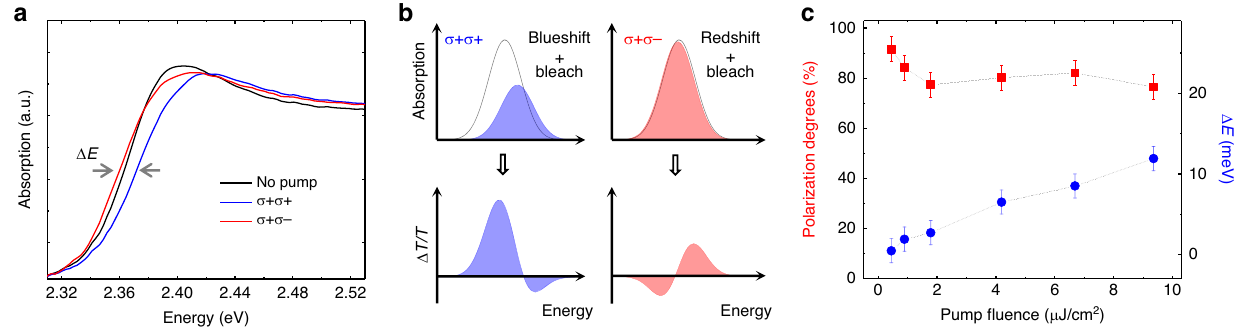
Fig. 2 The photoinduced circular dichroism in CsPbBr 3 at room temperature. a The absorption spectra without pump (black curve) and with pump at a deley time of 0.3 ps for σ + σ + (blue curve) and σ + σ − (red curve) pump – probe con fi gurations at room temperature. The horizontal gray arrows indicate energy shifts at the half maximmum of absorption band edge, which de fi ne the energy splitting ( Δ E ) between the blueshifted and redshifted absorption edges. The pump fl uence is ~9.4 μ J/cm 2 . b Schematics of pump-induced changes of the exciton resonance, mainly including the self-energy renormalization (blushift or redshift) and absorption bleaching, and the corresponding σ + σ + and σ + σ − TA spectra. c Pump- fl uence dependence of circular polarization degrees (red squares) and Δ E (blue circles) at 0.3 ps. The dashed lines are guide for the